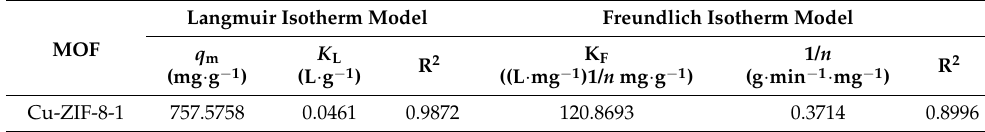
Table 3. Isotherm model parameters for OFX adsorbed on the Cu-ZIF-8-1.